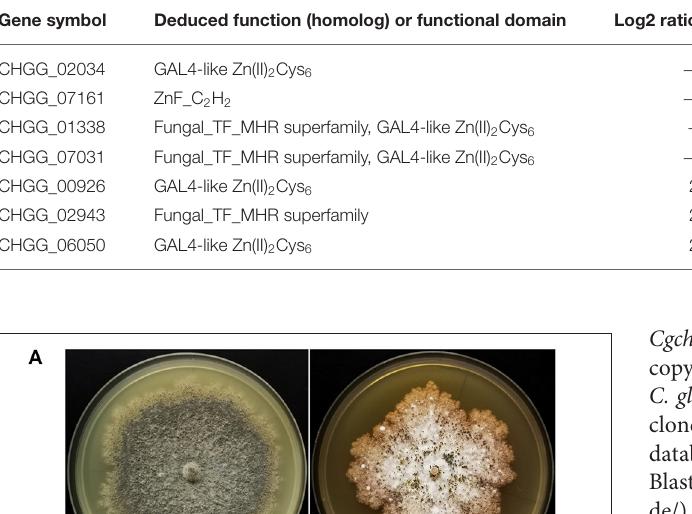
TABLE 2 | Putative zinc finger transcription factor genes with the top expression variation regulated by CgTF1 detected by RNA-seq profiling. Gene symbol